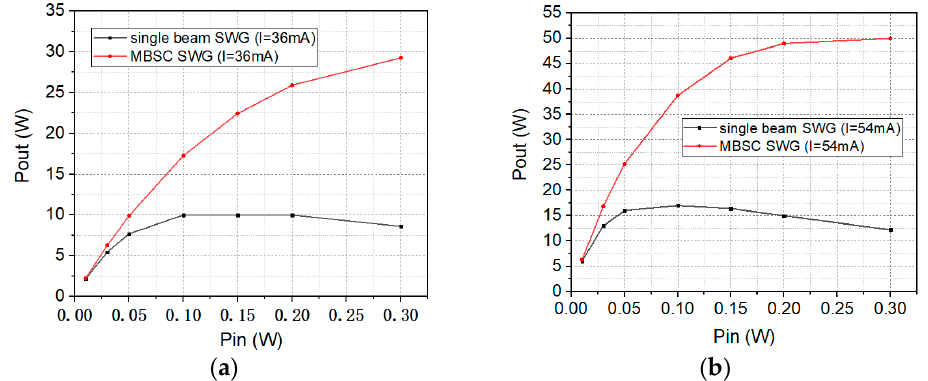
Figure 14. The output power versus the input power at 340 GHz. ( a ) I = 36 mA. ( b ) I = 54 mA.